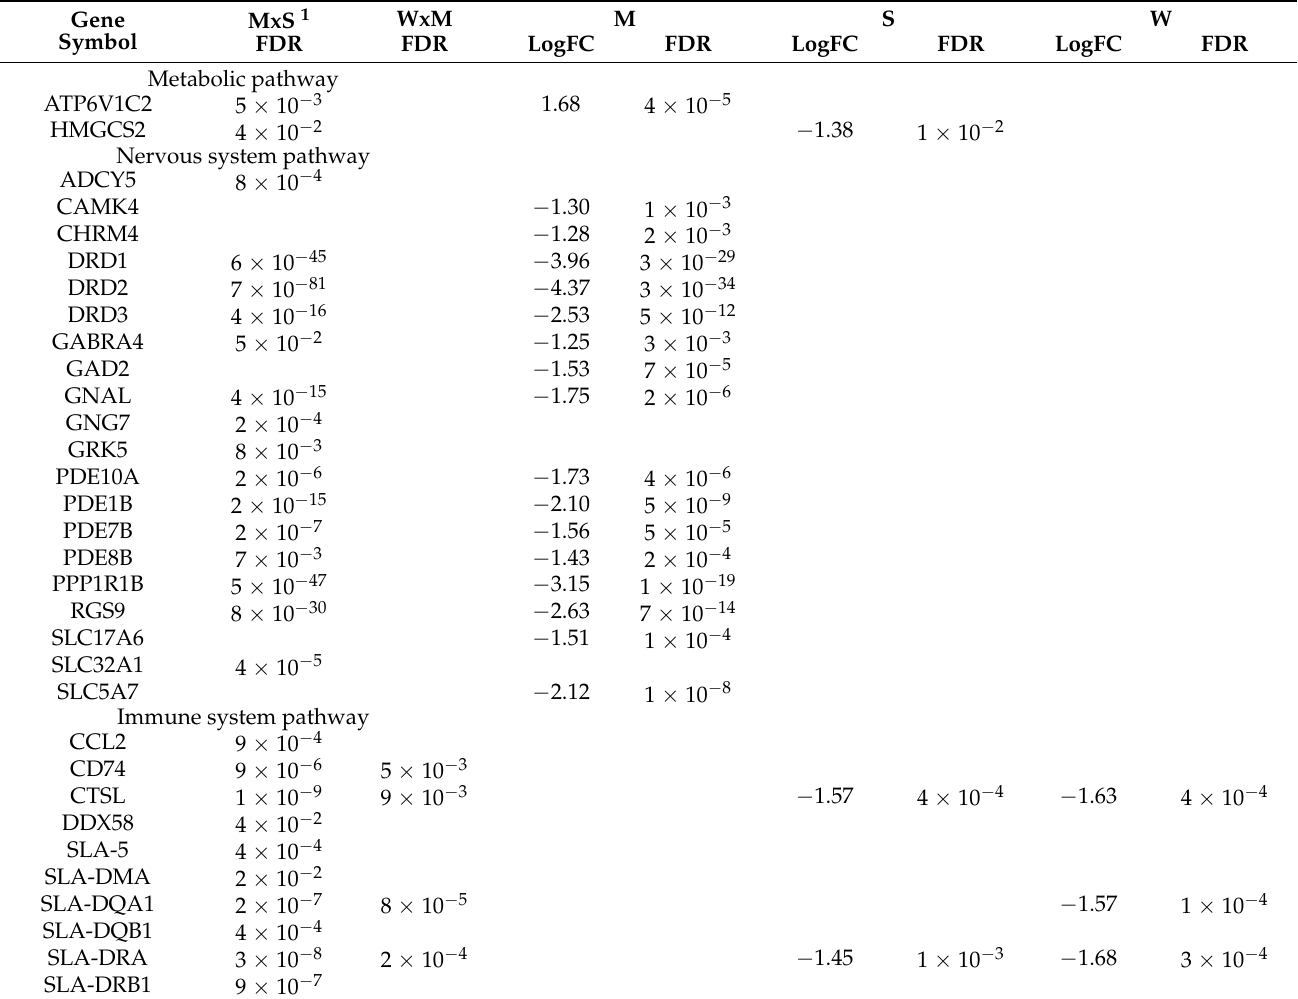
Table 2. Log2 (fold change) and False Discovery Rate-adjusted p -value (FDR) of genes in the hip- pocampus that presented at least one significant (FDR p -value < 0.05 and a |log2 (fold change between pig groups)| > 1.2) interaction or main effect of weaning (W), maternal immune activation (M), and sex (S) in the pathways enriched at a FDR-adjusted p -value < 0.05 and a normalized enrichment score |NES| >